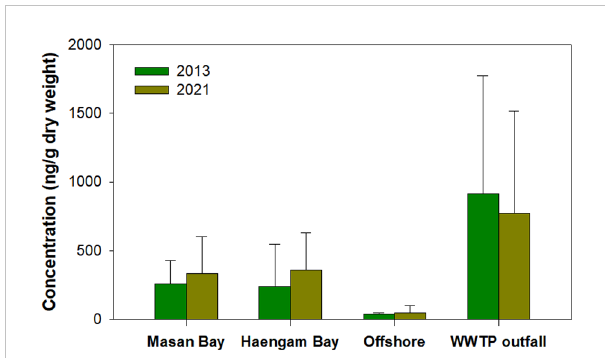
FIGURE 4 Time trends in the concentrations of siloxanes in sediment from Masan and Haengam Bays, offshore, and the submarine outfall of a wastewater treatment plant collected between 2013 and 2021.